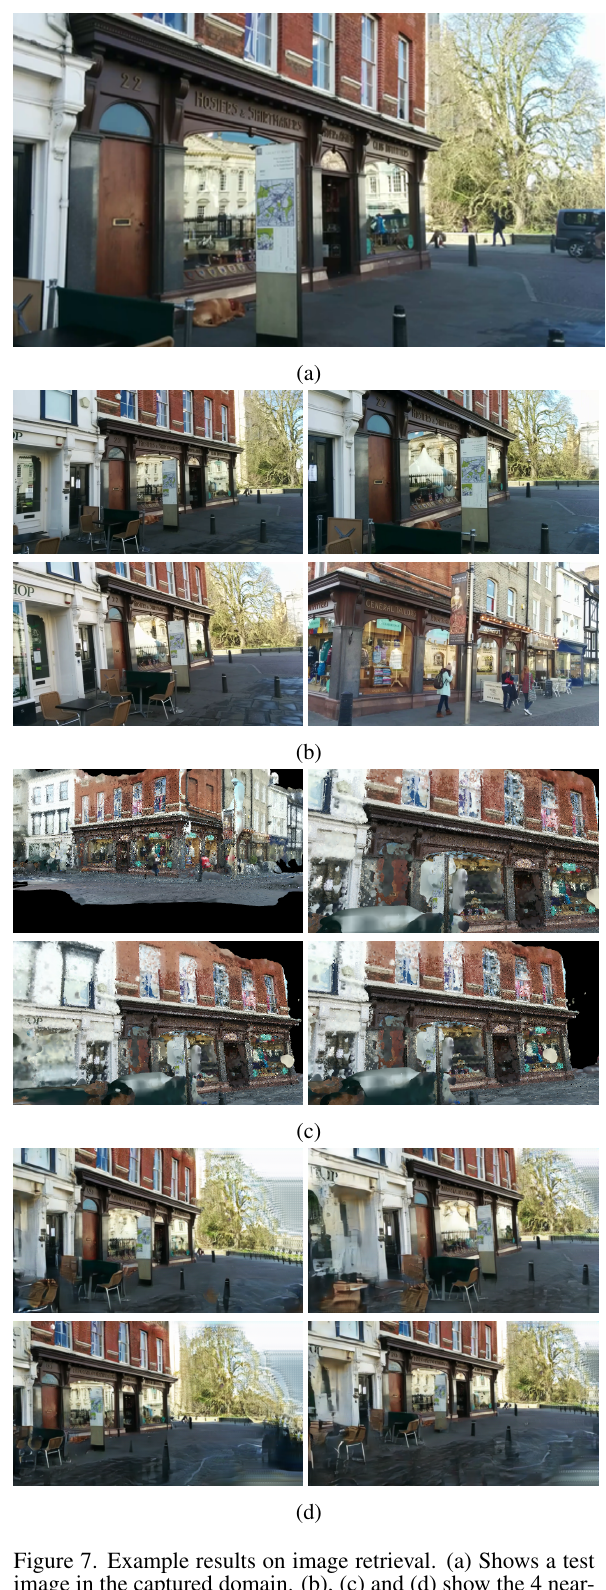
models. The test results are depicted in Table 3. The network achieved a pose accuracy as median translation and rotation er-